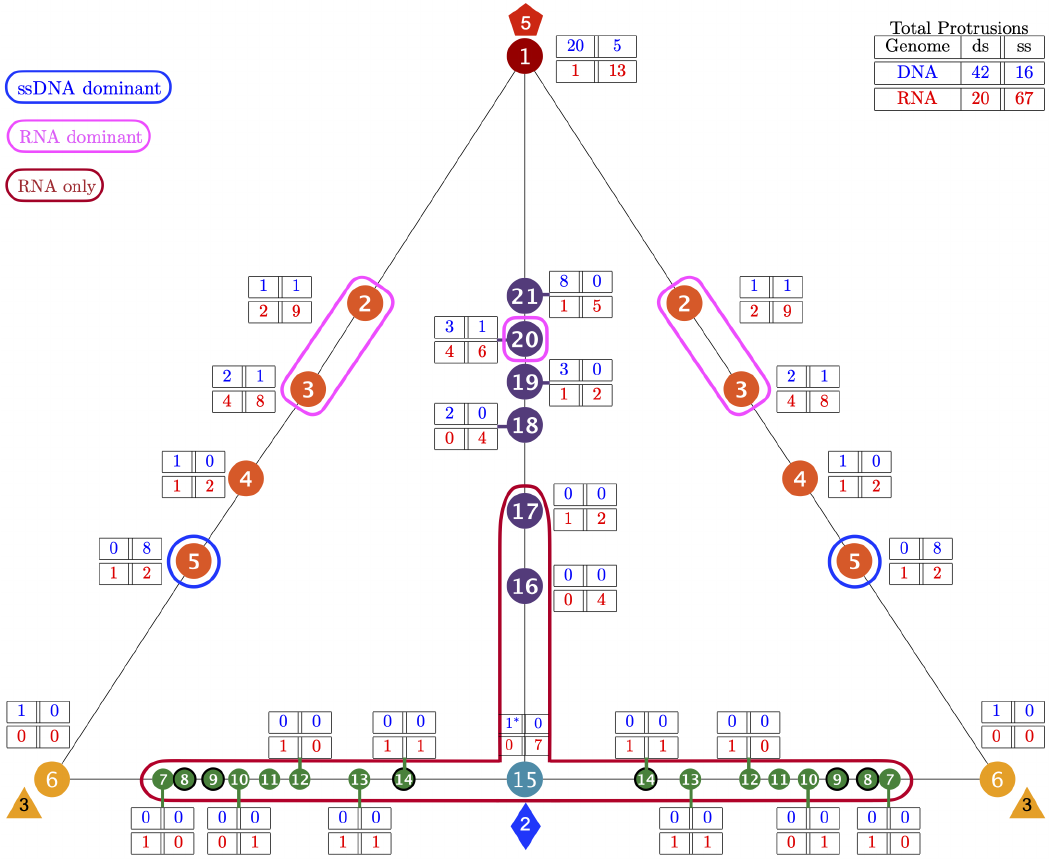
Figure 6. The 149 distinct structural protrusions and their corresponding genomes mapped onto the 21 unique gauge points of the Asymmetric unit (AU) [2]. The total number of protrusions for each genome is shown in the upper right. The region encircled in red, GP 7 to GP 17 was found to only have RNA viruses (Baltimore Classifications III, IV, and V). There is one technical exception to this observation, HBV forms a mixture of the T3 (5%) and a T4 (95%) capsids. The T3 capsid (6bvn) has two structural protrusions at GP 3 and GP 15; however, the T3 capsid is too small to package the DNA genome inside [32,33]. The regions encircles in pink (GP 2,3 and 20) are dominated by RNA viruses (71% or more). Gauge point 5 is encircled in blue and primarily used by T1 capsid with ssDNA (73%). Gauge points 1, 4, 18, 19 and 21 are equally utilized by RNA and DNA viruses. This visualization elucidates the new utility of Viral Phrenology, as a predictor of genome composition based on location of